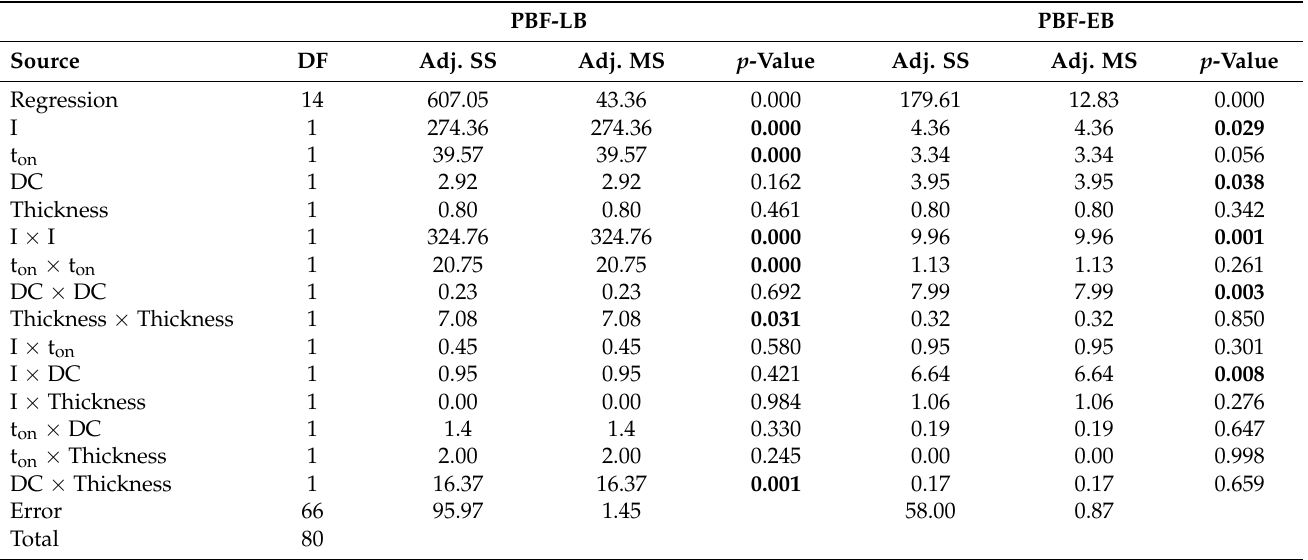
Table 8. ANOVA table of process parameters and their interactions for Rax in the case of the PBF-LB and PBF-EB processes (the significant factors or interactions are highlighted in